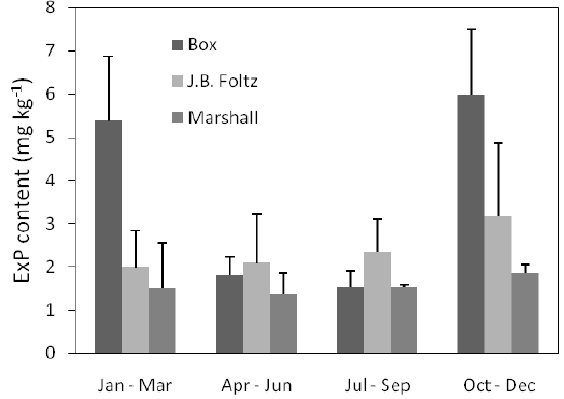
Figure 4. Average exchangeable content in sediments in the P three